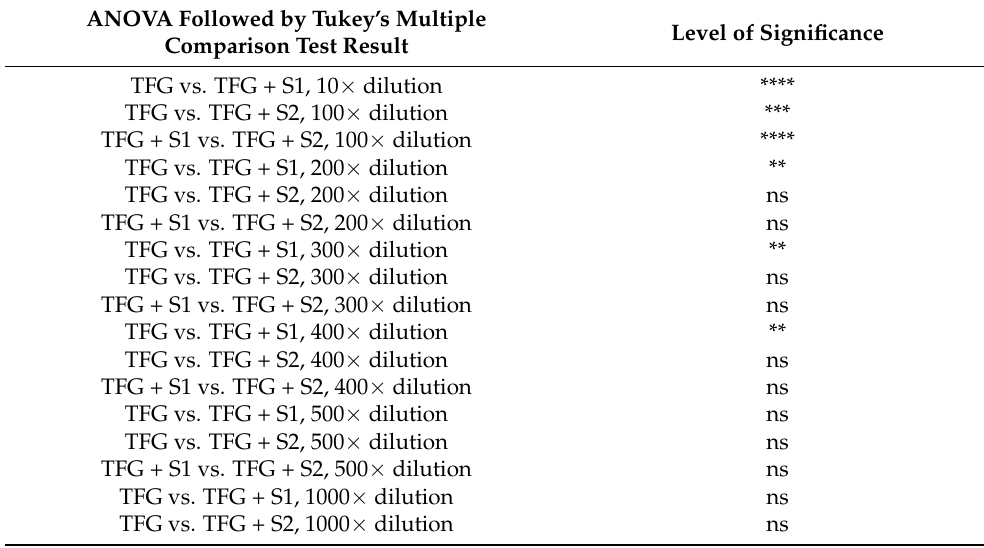
Table 2. One-way ANOVA test followed by Tukey’s multiple comparison test performed on the